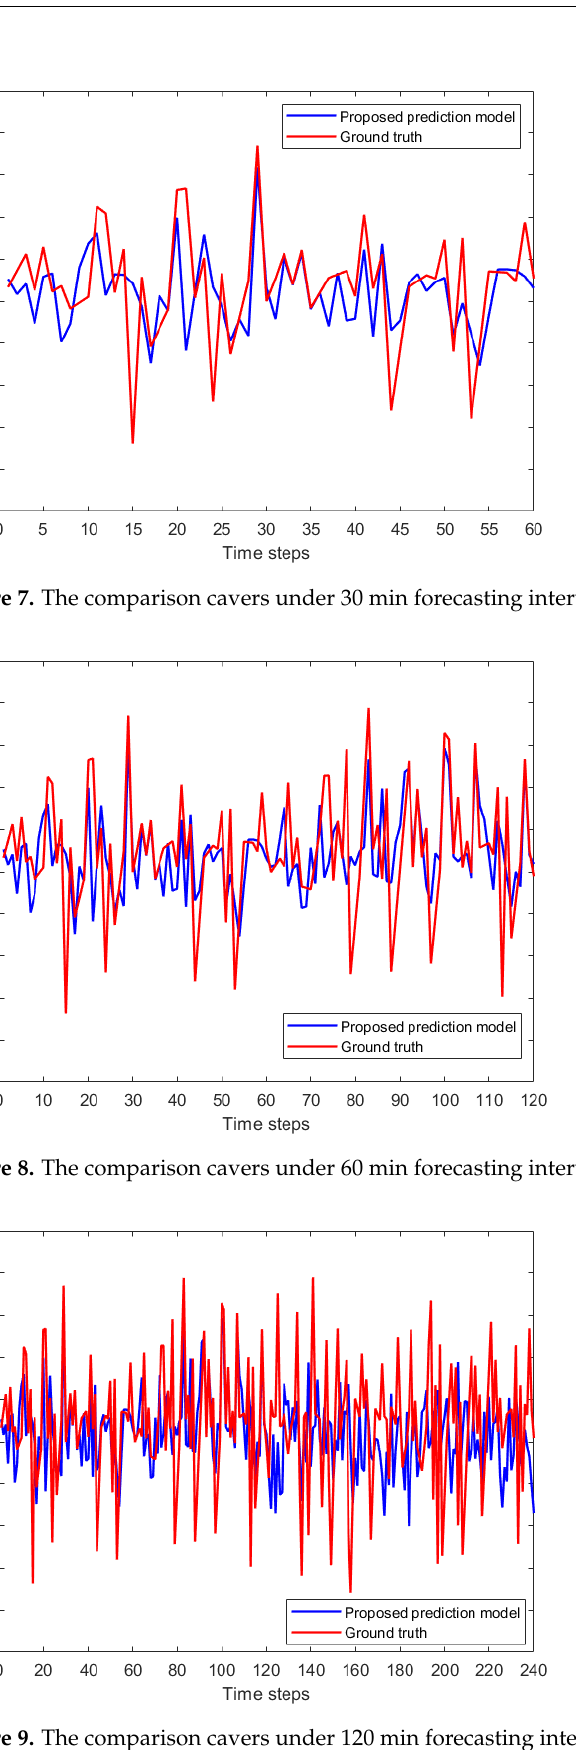
Figure 9. The comparison cavers under 120 min forecasting